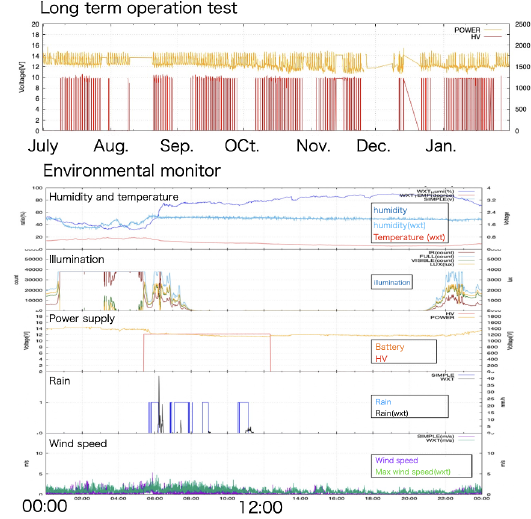
Figure 13. Example of the monitor plot of the automation system in long-term